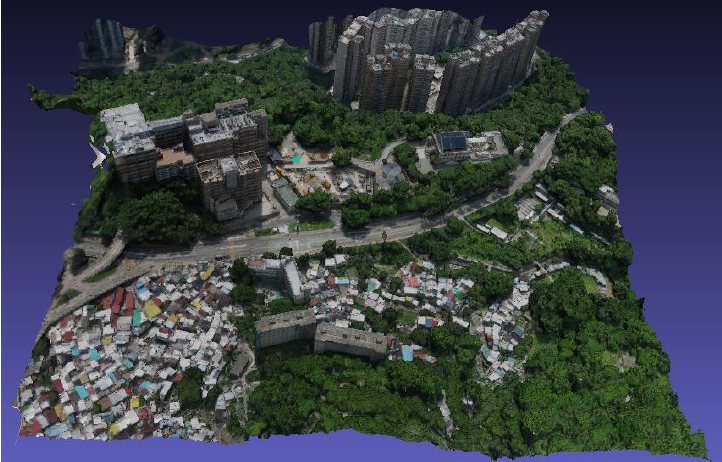
Fig.6. The final texture map and textured model